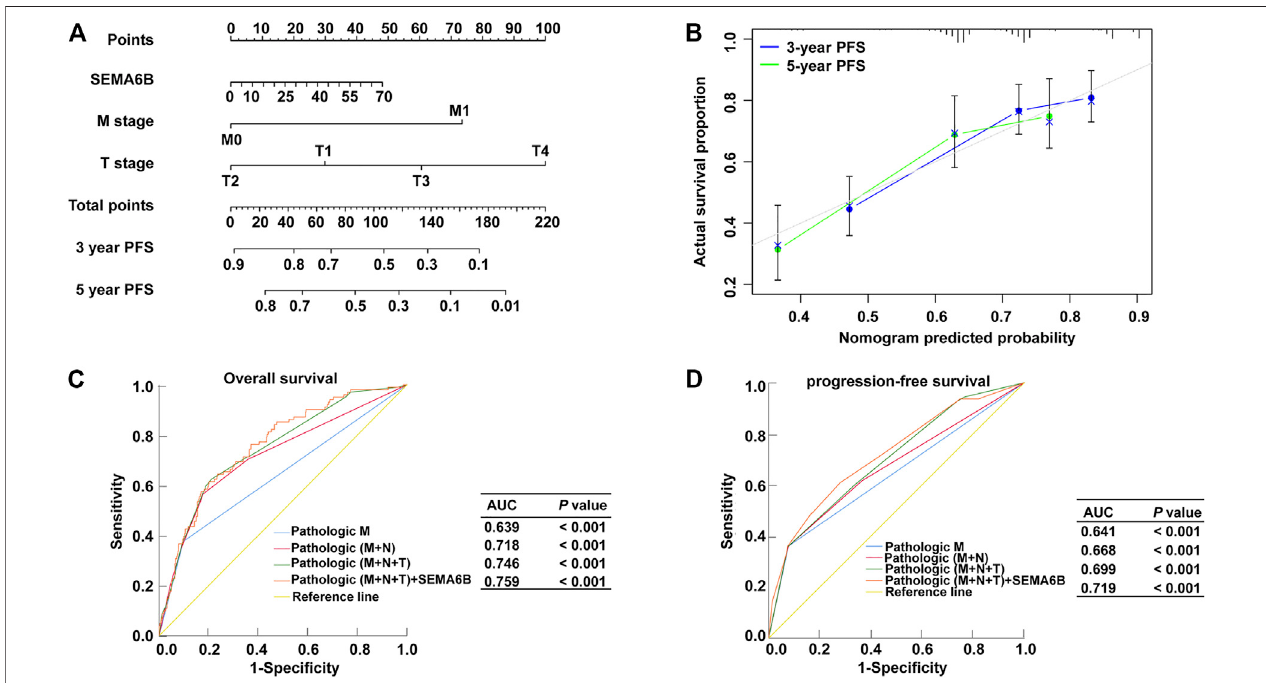
FIGURE 5 | Nomogram model and ROC for survival prediction of CRC members. (A) Nomogram model to predict 3, and 5 years associated PFS probability. (B) The calibration curve of the nomogram when predicting 3- and 5 years PFS probability. ROC curves for predicting OS (C) and PFS (D) in CRC patients via prognostic models from the TCGA dataset. The x -axis indicates the false-positive rate, which is presented as ‘ 1-Speci fi city ’ . The y -axis indicates the true-positive rate, which is designated as “ Sensitivity ”